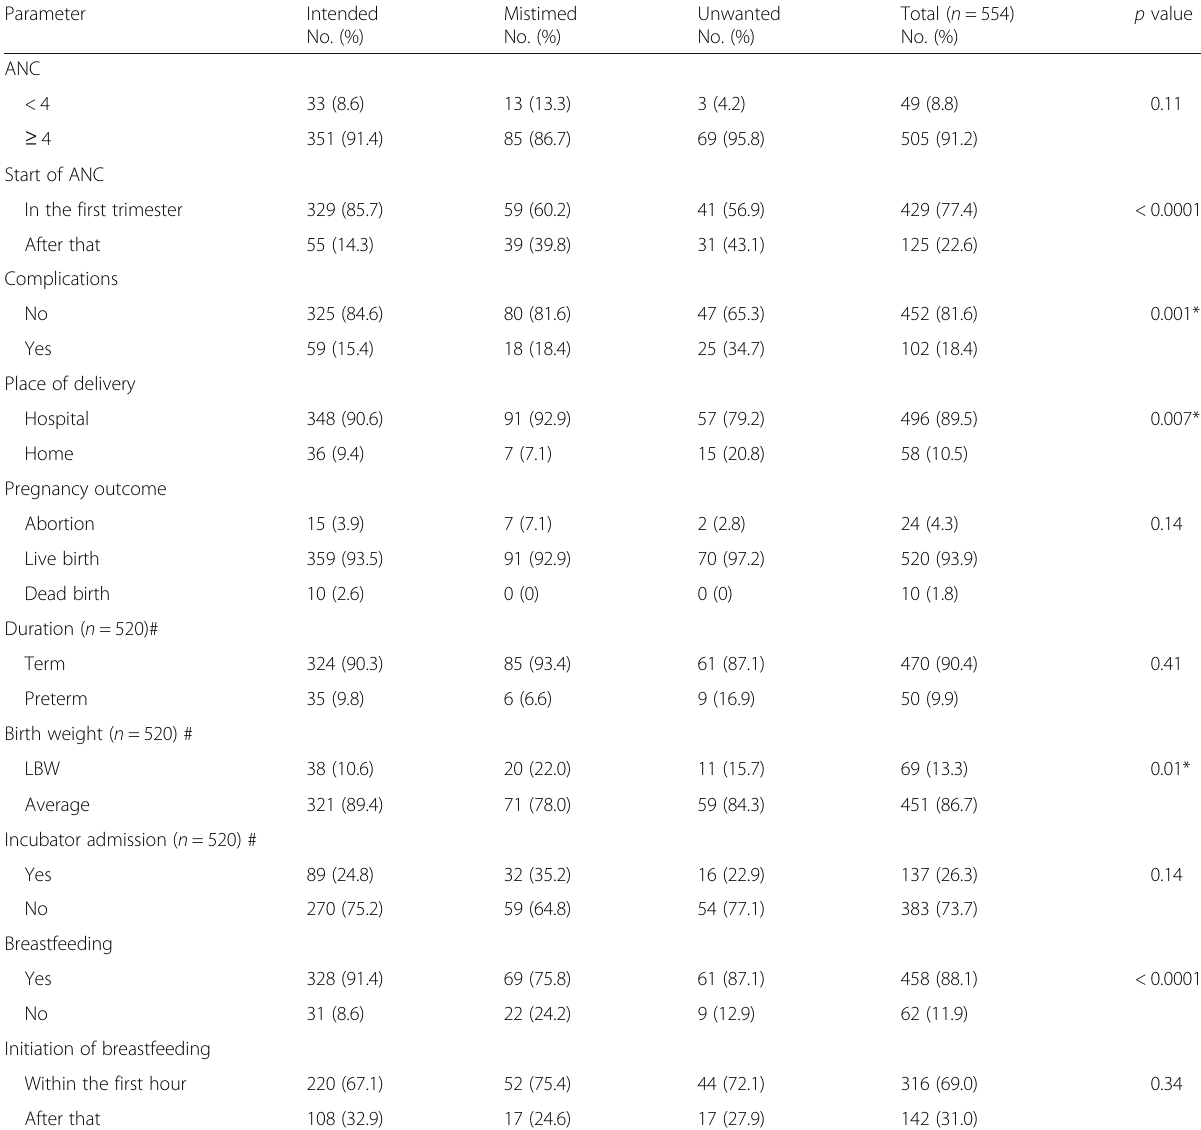
Table 4 Relation between pregnancy intention and pregnancy outcomes, Sohag district, Egypt, 2016